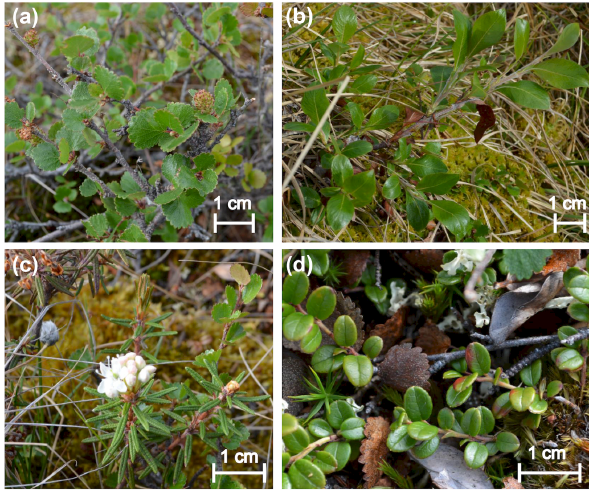
Figure 1. Study species: Betula nana (a) , Salix pulchra (b) , Ledum palustre (c) and Vaccinium vitis-idaea (d)